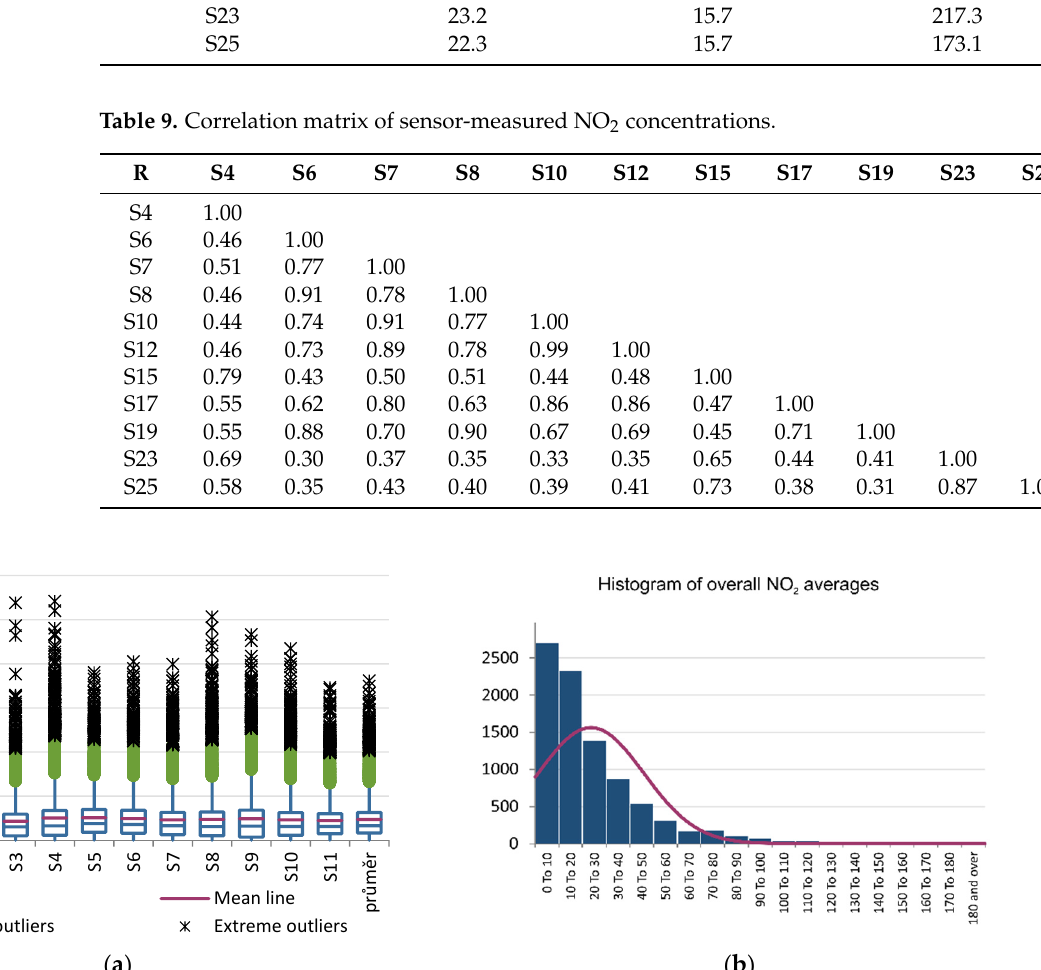
Figure 6. Distribution of NO 2 values throughout the year-long measurement: ( a ) box plot for individual sensors and ( b ) histogram of hourly averages (overall averaged values of all sensors).